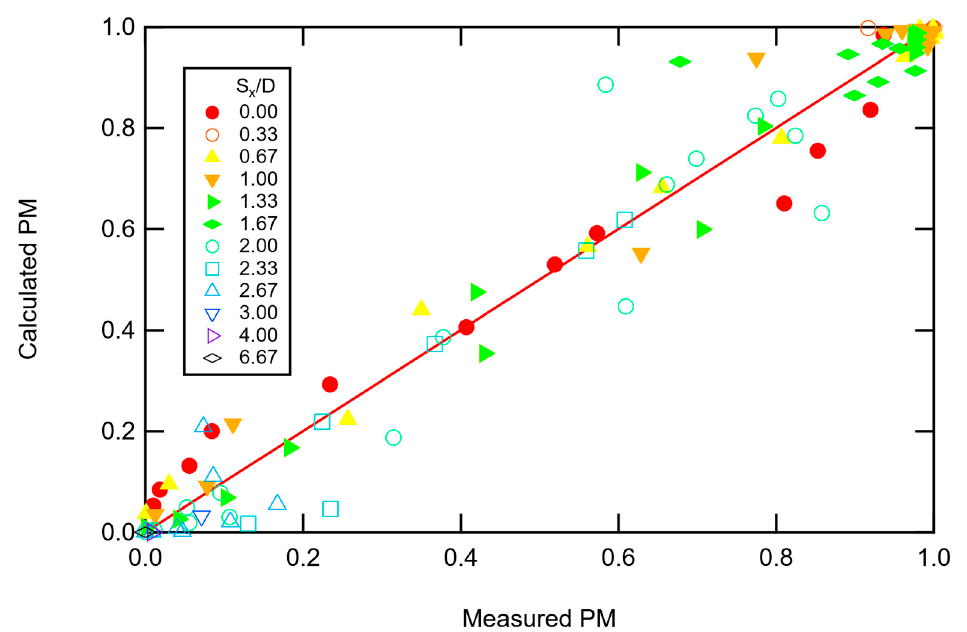
Figure 8. Merging probability ( PM ) as a function of normalized distance for the two-pad experiments. Lines are the curve fits using Equation (6). Error bars omitted for ease of viewing.